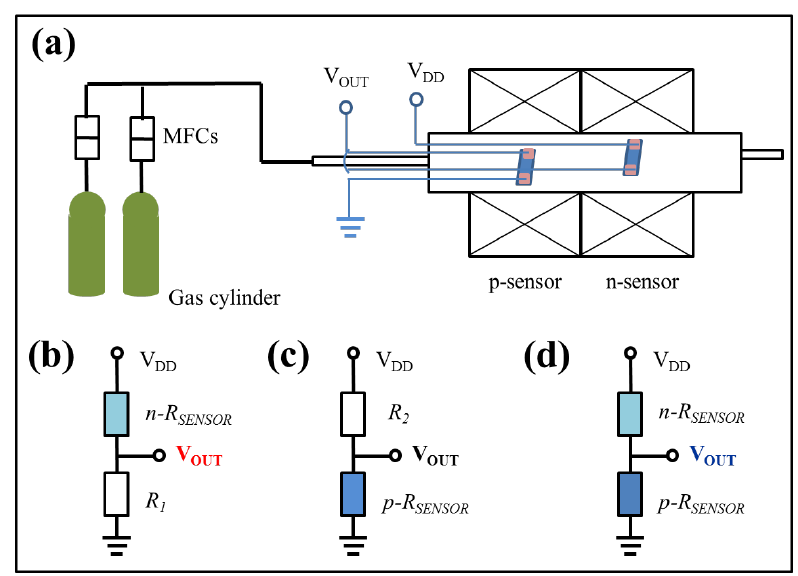
Figure 1. Schematics of the ( a ) gas sensor measurement system, ( b ) n-sensor, ( c ) p-sensor, and ( d ) p + n sensor array circuits.